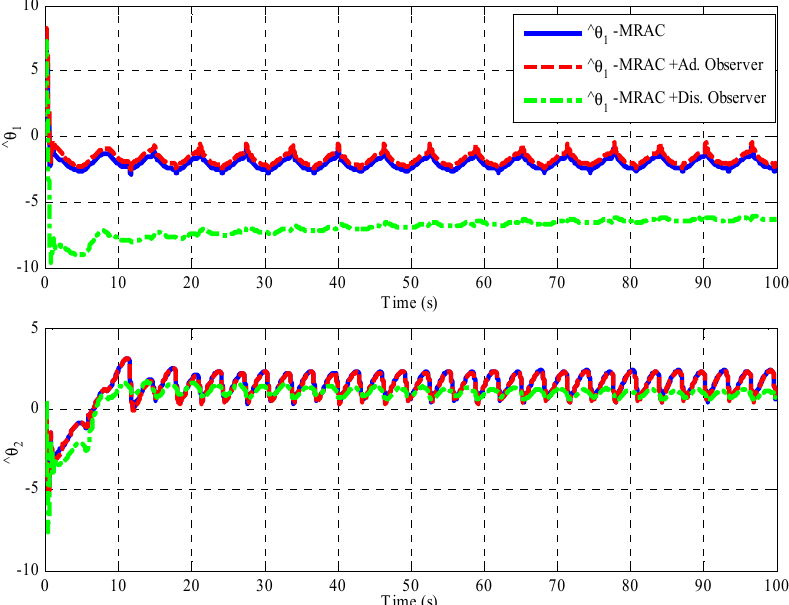
Figure 6. Uncertainty compensation adaptive gains for the three controllers.